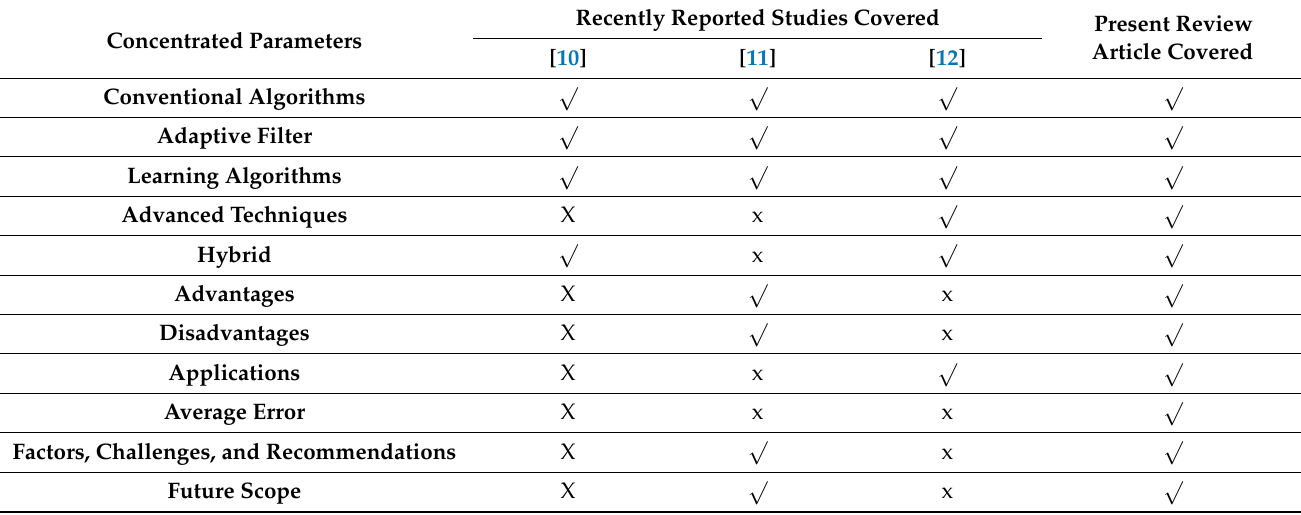
Figure 1. The number of research articles on Li-ion battery SOC estimation per year. Table 3. Summary of recently reported studies covered and review articles covered.